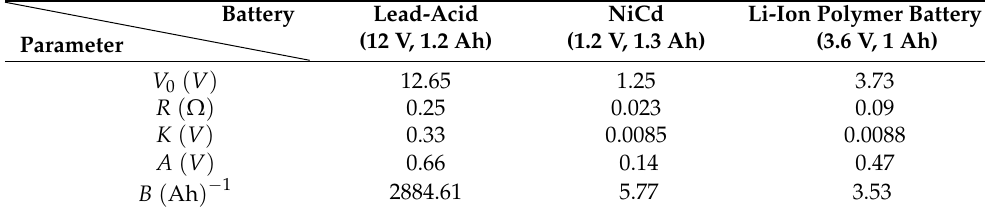
Table 3. Conventional batteries-controlled voltage source parameters. Battery Parameter